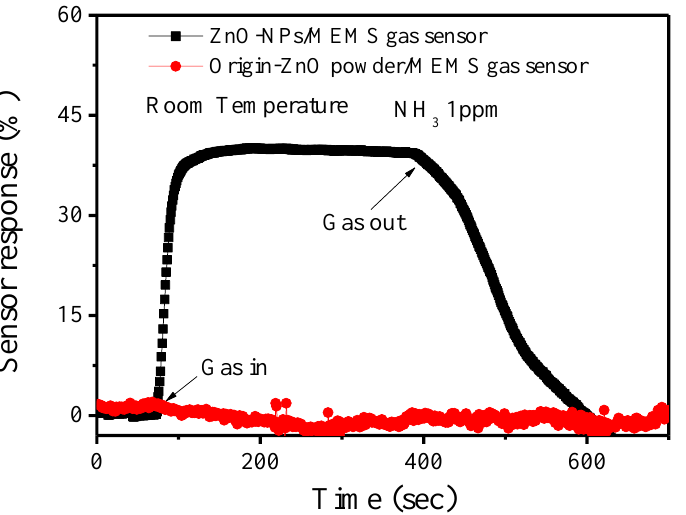
Figure 7. The sensor response for the origin-ZnO powder/MEMS gas sensor and the ZnO- NPs/MEMS gas sensor.